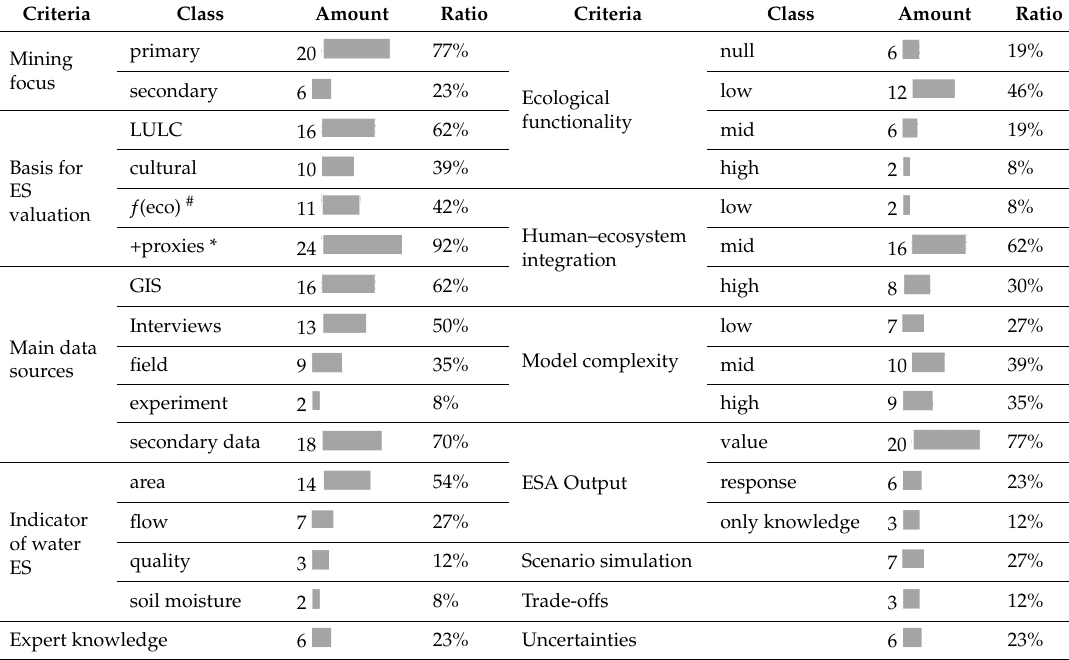
Table A2. Quantitative results of the applied reviewing